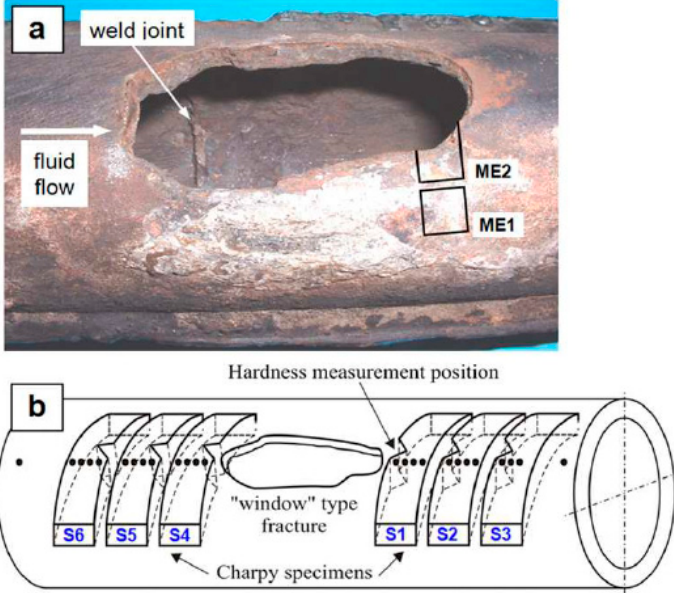
Figure 5. ( a ) damaged boiler tube facture; ( b ) position of facture on the boiler tube